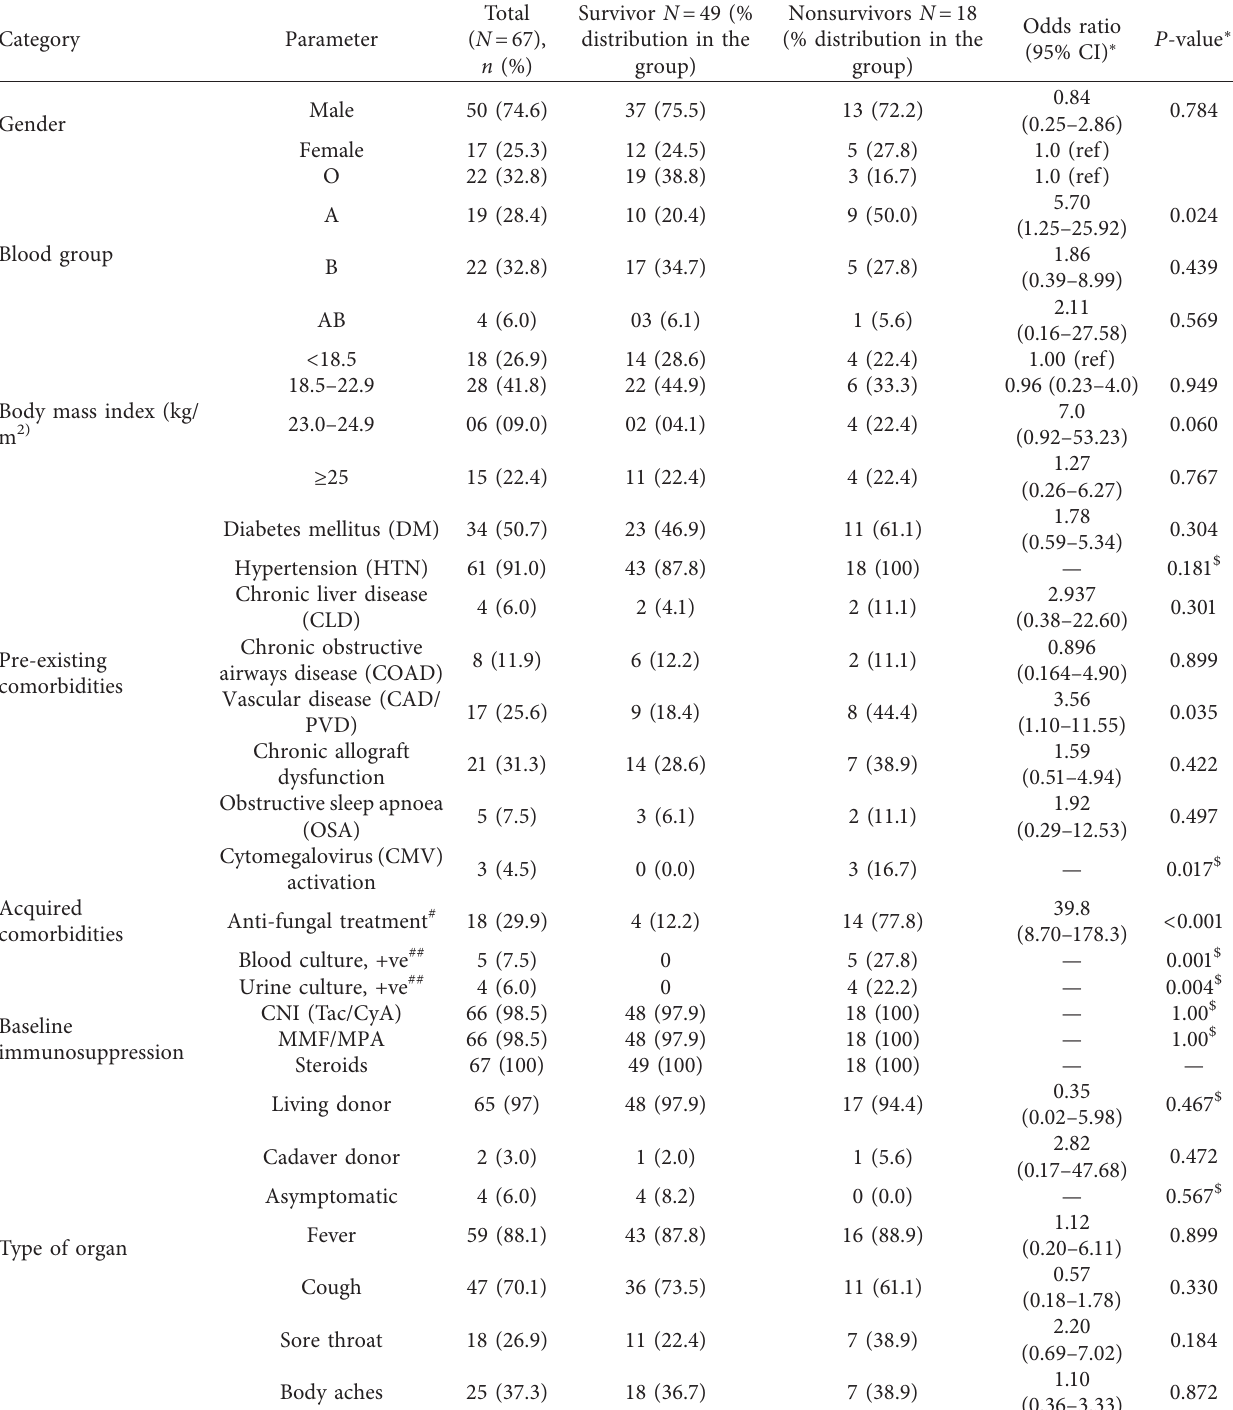
Table 1: Characteristics, comorbidities, and symptoms of kidney transplant recipients with